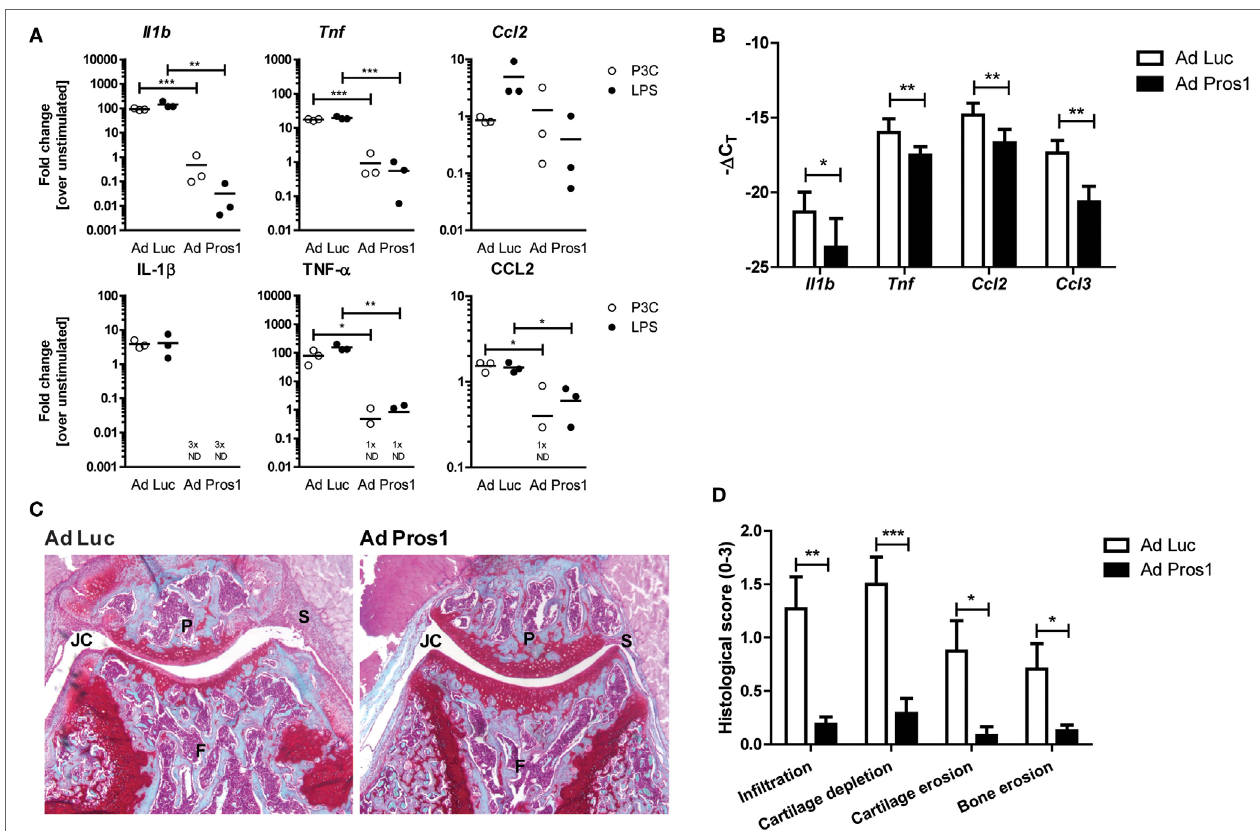
FigUre 2 | Outcome on inflammation and arthritis pathology following adenovirally overexpressing Pros1 in KRN serum transfer arthritis (STA). (a) Bone marrow- derived macrophages were transduced with Ad Luc or Ad Pros1 and stimulated with lipopolysaccharide (LPS) or P3C for 6 (top) or 24 h (bottom). Messenger RNA was extracted and gene expression was determined (top). Supernatants were analyzed (bottom). Data are representative for two independent experiments ( n = 3 per experiment). (b) KRN STA was induced in mice intra-articularly injected with Ad Luc or Ad Pros1 ( n = 9 mice). Knee synovial biopsies were obtained, mRNA was extracted and gene expression was determined ( n = 6 knee synovial biopsies). (c) Shown are representative pictures of knee joint sections stained with safranin O and fast green. (D) Histological knee joint sections were scored for the arthritis parameters depicted. Three semi-serial sections per joint were scored in a random and blinded manner with an arbitrary score from 0 to 3 ( n = 12 knee joints). P, patella; F, femur; S, synovium; JC, joint cavity. For (a) , data are presented as dot-plots with mean. For (b–D) , data are represented as mean + SEM. * p < 0.05, ** p < 0.01, *** p < 0.001 with unpaired t -test. See also Figures S1 and S2 in Supplementary